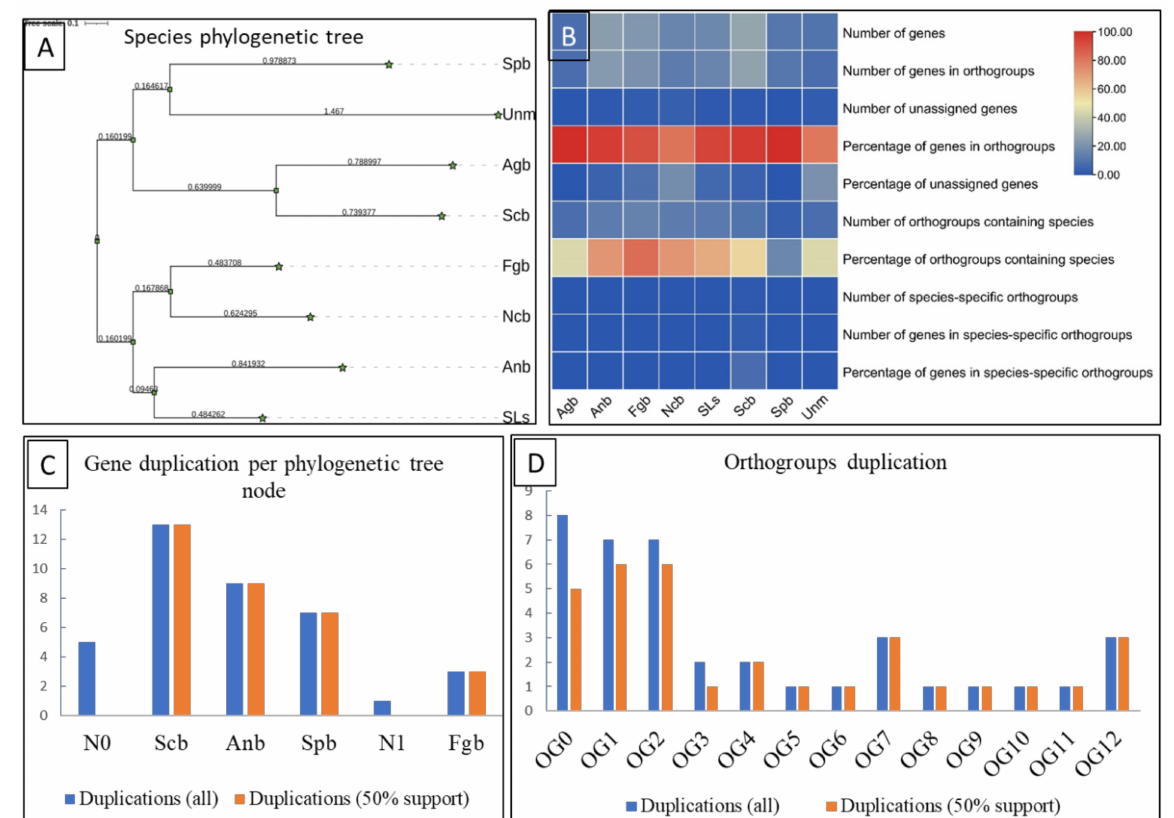
Figure 3. Evolutionary study of bZIP in Fungal species. ( A ); bZIP Based phylogenetic tree of species Schizo saccharomyces pombe (Spb), Ustilago maydis (Unm), Ashbya gossypii (Agb), S. cerevisiae (Scb), Fusar- ium graminearum (Fgb), N. crassa (Ncb), A. nidulans (Anb), Sclerotinia sclerotiorum (SLs), ( B ); Orthologs summary, ( C ); Gene duplication events among fungal species, ( D ); orthogroups duplication events in all 135